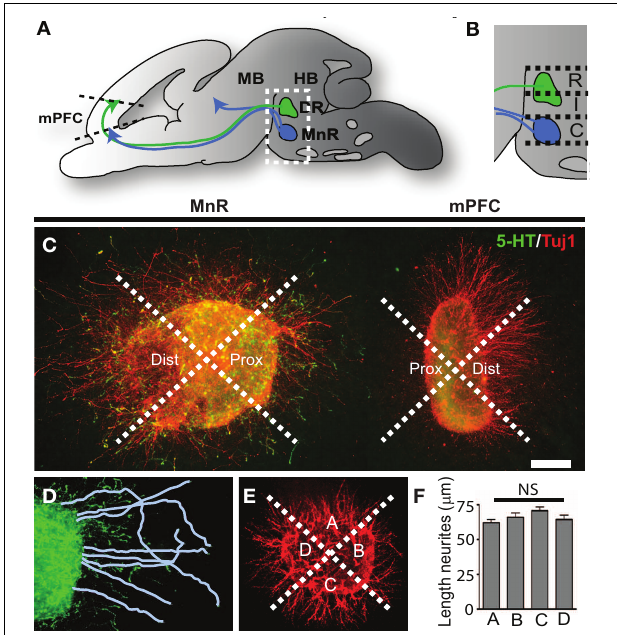
FIGURE 1 | Three-dimensional collagen co-cultures of explants taken from the mPFC, DR, and MnR show trophic responses. (A) Schematic of an embryonic brain showing the position of the 5-HT-positive rostral cluster of raphe nuclei projecting to the mid- and forebrain. The dorsal raphe nucleus (DR) projects to forebrain regions (green arrow) including the prefrontal cortex (mPFC). The median raphe nucleus (MnR) projects (blue arrows) to fore-and midbrain regions. (B) Enlargement of the boxed area in (A) . The rostral (R) and intermediate (I) subarea correspond to the DR and the caudal (C) subarea corresponds to the MnR. (C) Example of a 5-HTT + / − caudal subarea (MnR) co-cultured with mPFC, divided in proximal and distal quadrants and stained for 5-HT (5-HT neurites, green) and Tuj1 ( β -III tubulin, all outgrowing neurites, red). (D) In the proximal (and distal, not shown) quadrants the neurites are traced and measured. (E) Control explants were cultured separately and neurite outgrowth was measured in the 4 quadrants (example of WT mPFC). (F) The average length of the neurites in quadrants A, B, C, or D showed no significant (NS) difference. HB, hindbrain; MB, midbrain. Scale bar represents 80 μ